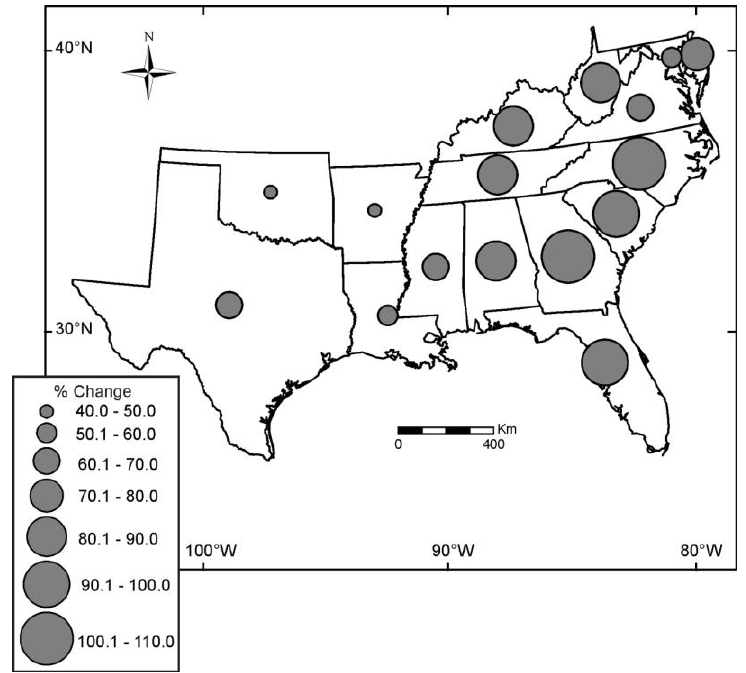
Figure 3. Changes in the extent of developed land (urban and transportation lands) in the southern U.S. from 1982–2007 (source: 2007 National Resources Inventory; USDA,